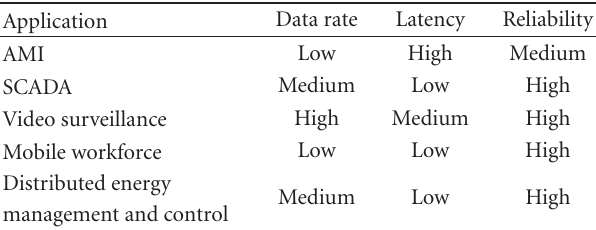
Table 1: Communication requirements for some smart grid